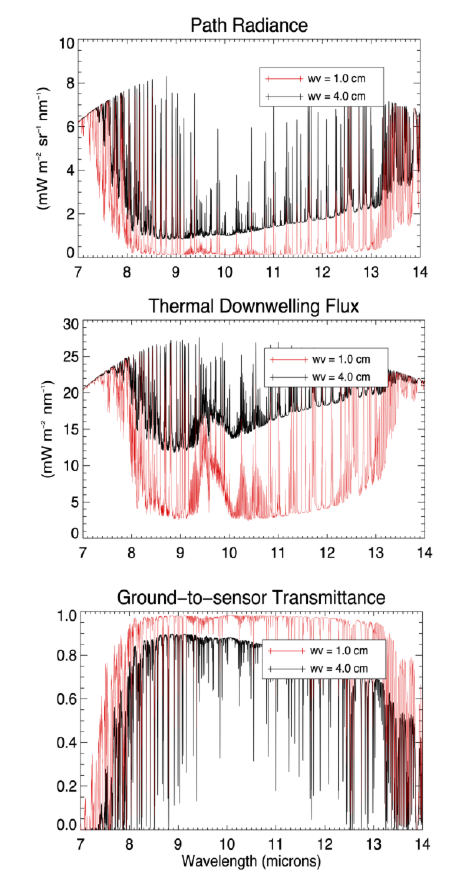
Figure 2. Exemplary atmospheric influence functions in the TIR (from top: path radiance, downward thermal flux, and transmittance). The spectra were simulated for a nadir viewing instrument flying at 500 meters above ground and a surface altitude at sea level. The black lines show libRadtran computations for an atmospheric water vapor column of 1.0 cm und the black lines for water vapor column of